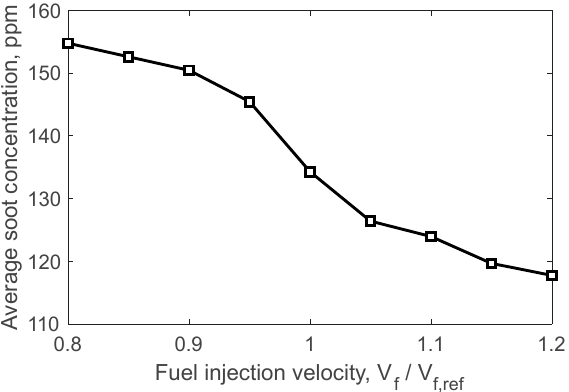
Figure 19. E ff ect of the fuel injection velocity on the soot concentration. Figure 19. Effect of the fuel injection velocity on the soot